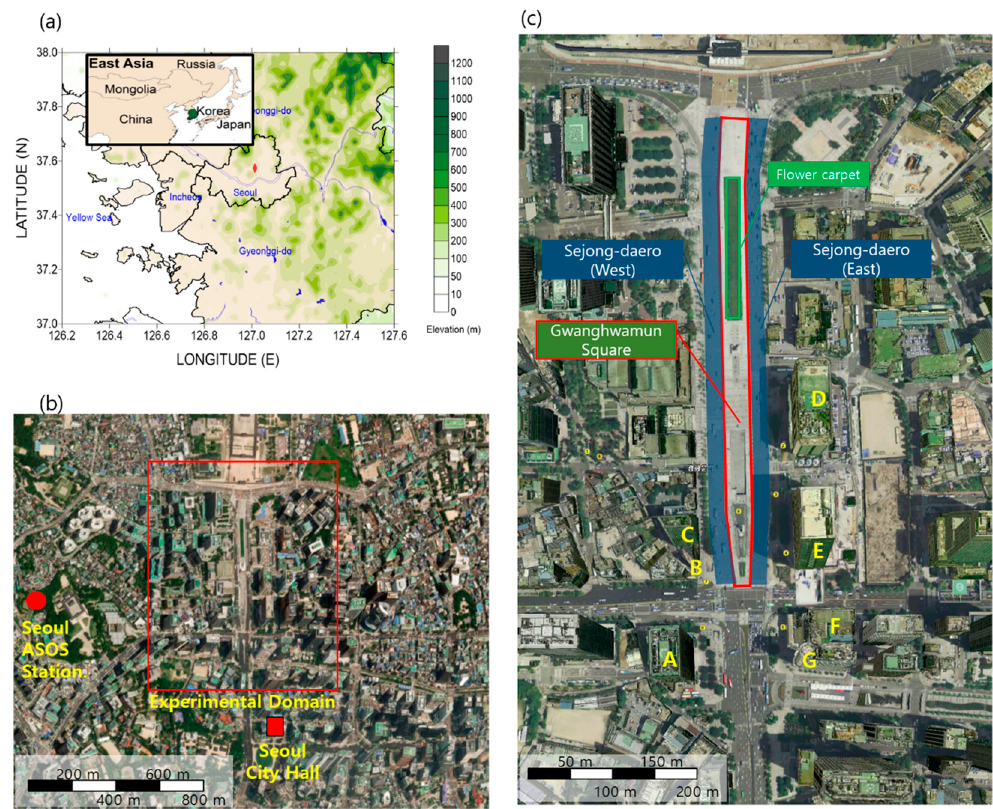
Figure 1. ( a ) Location of experimental site (red closed diamond) in Seoul Metropolitan Area, Korea, East Asia; ( b ) satellite image near the experimental domain; ( c ) location of Gwanghwamun Square and Sejong-daero Streets (East and West) and Buildings A–G in the enhanced 3-dimensional building map near the experimental site.